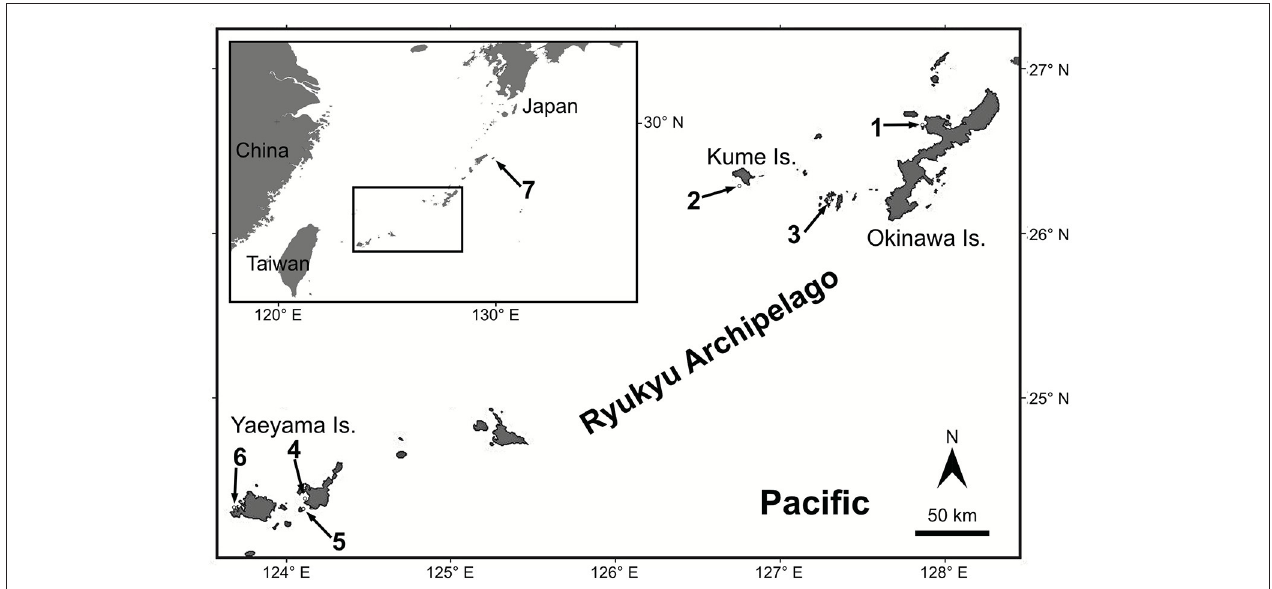
FIGURE 1 | Map of the studied area. Numbered arrows point at the sampling locations. 1. Shigeo’s Reef, offshore Sesoko and Okinawa Island, 2. Kume Island, 3. Aka Island, 4. Nagura Bay in Ishigaki Island, 5. Taketomi Island, 6. Amitori Bay and Cape Sabazaki in Iriomote Island, 7. Kikai Island.